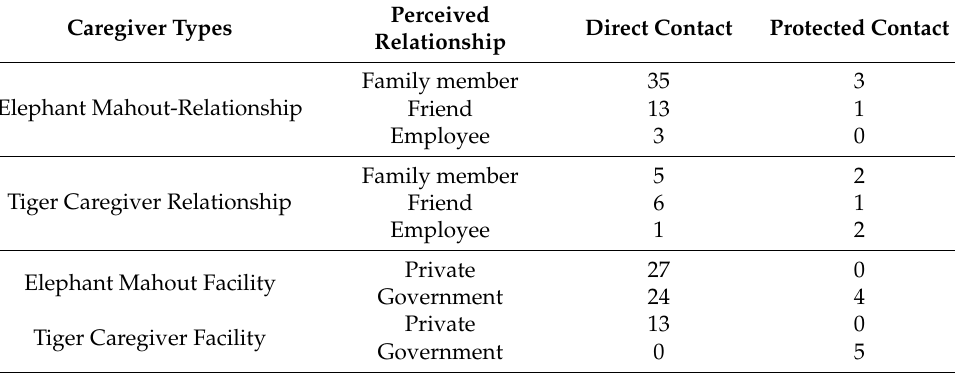
Table 5. Caregiver’s relationship with the animal and facility context, with direct contact versus protected